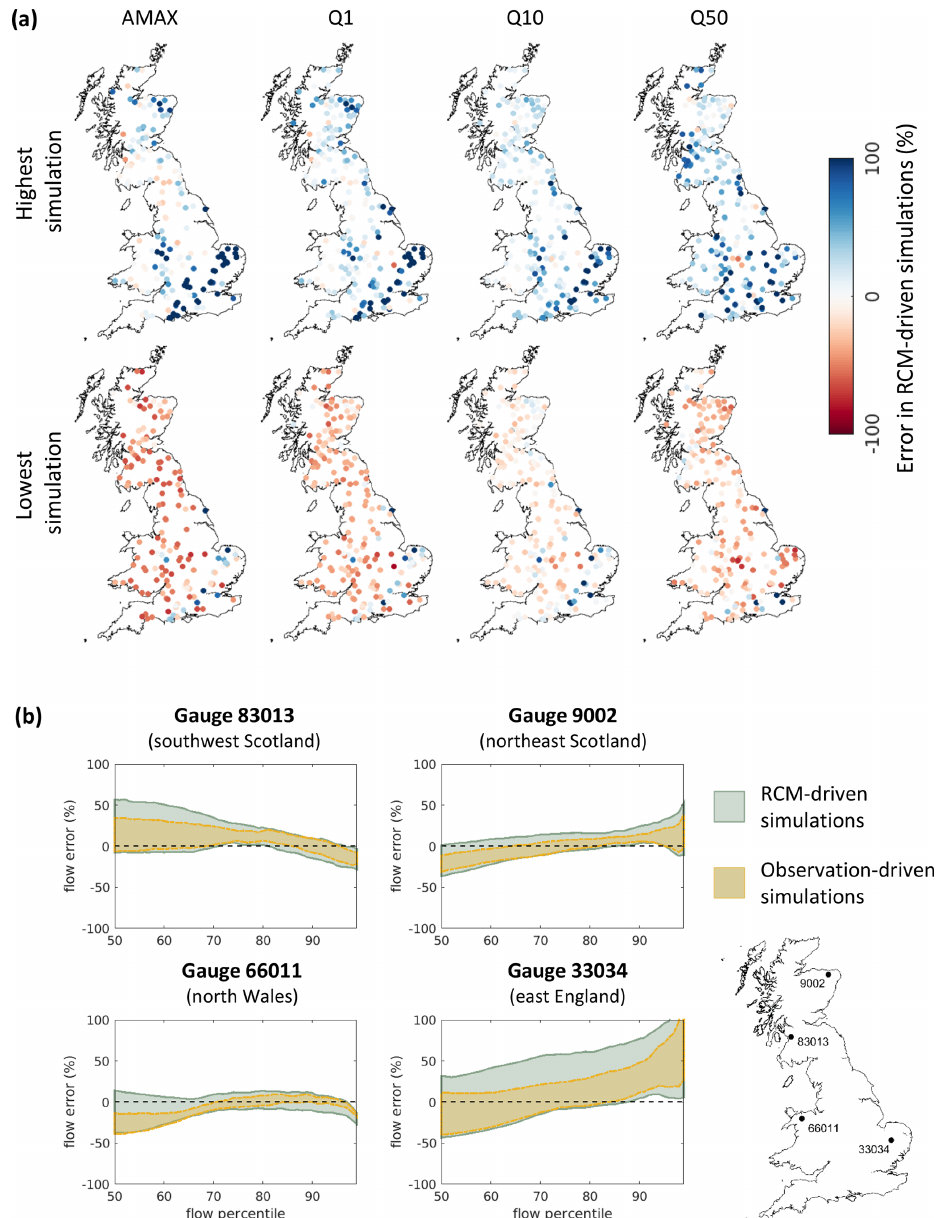
Figure 3. Evaluation of model performance, showing how well the modelled flow statistics from the climate–hydrological cascade bound the observed flow statistics over the baseline period. The maps (a) show errors in RCM-driven simulations compared to the observed ones. The top row shows the highest positive error from the 360 simulations, while the bottom row shows the lowest negative error, calculated separately for each catchment. When considered together, these show how well the RCM-driven simulations bound the observed flows. Four gauges are shown in more detail (b) , giving error across median and higher flow percentiles compared to observations, showing both simulations driven by observations and simulations driven by RCM